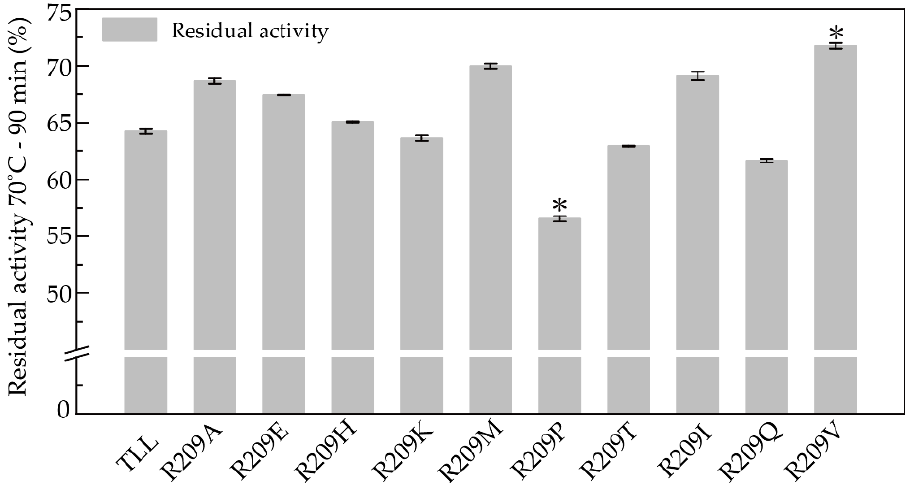
Figure 3. Residual activities of TLL and the ten R209 mutants. The residual activity was tested by incubating all lipases at 70 °C for 90 min. R209 mutants with one star indicate the differences of residual activity are significant at the 0.05 level.